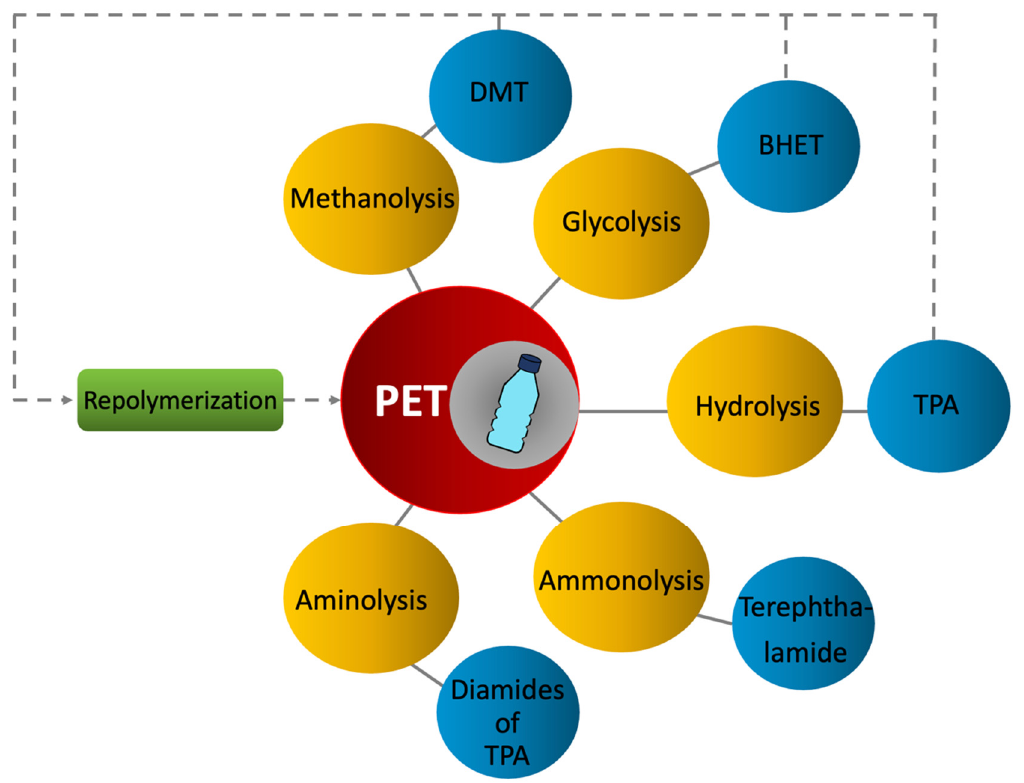
Figure 3. Chemical recycling of PET.